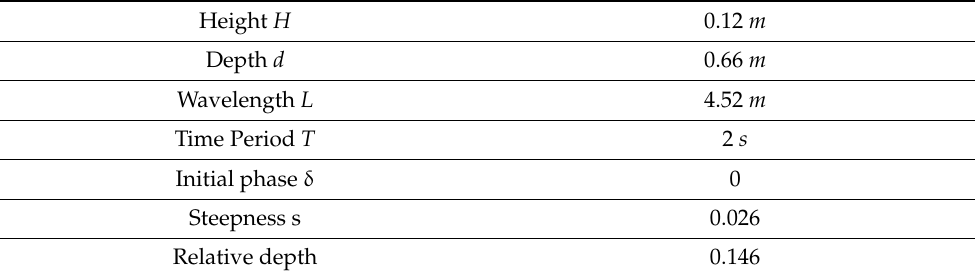
Table 3. Wave conditions for the monochromatic wave used in the